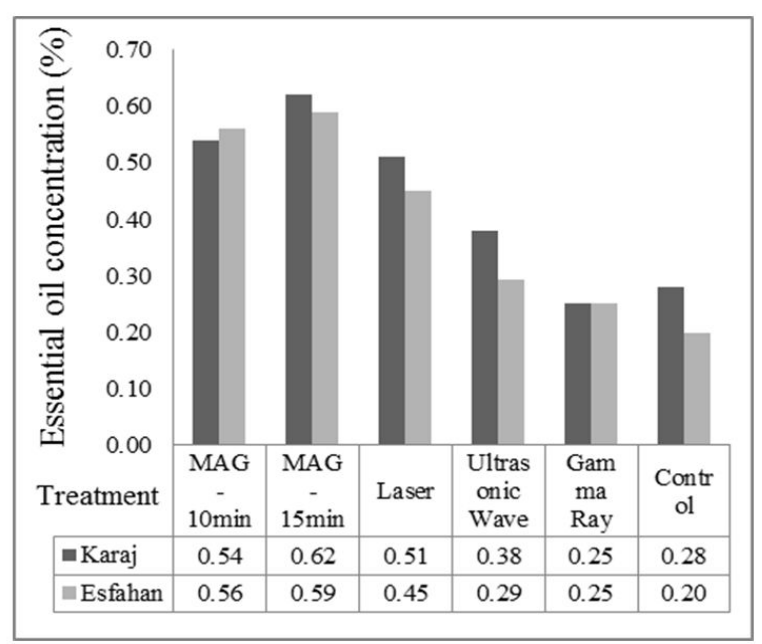
Fig. 2. Essential Oil concentration (%)of two landraces as affected by physical priming